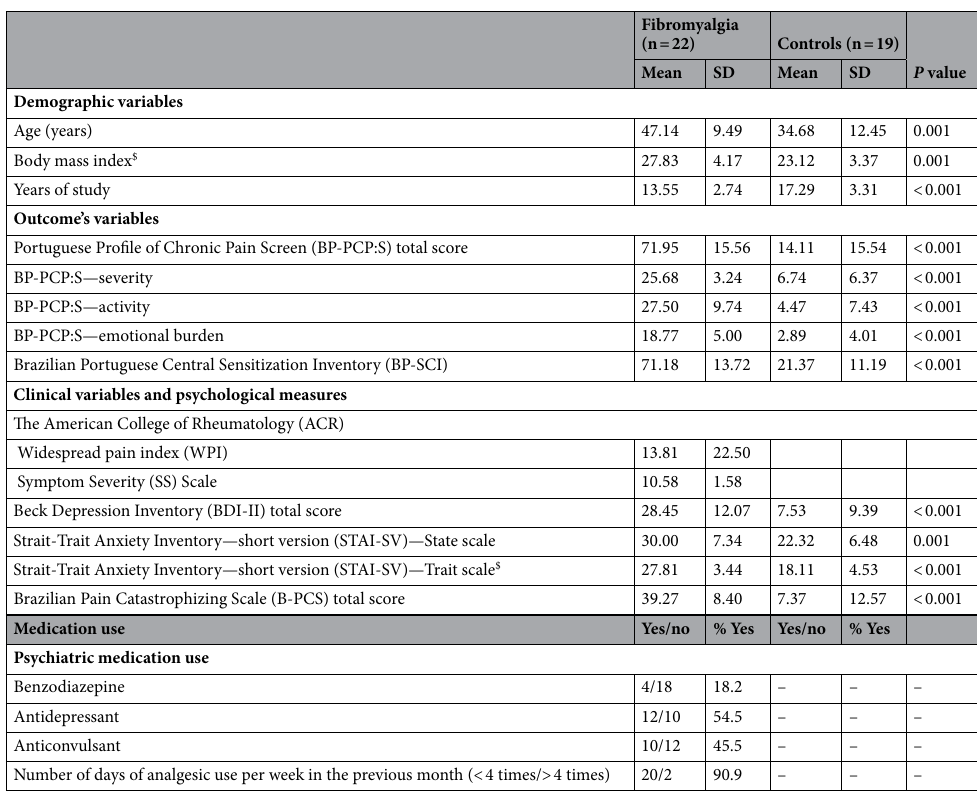
Table 1. Demographic and clinical characteristics for the total sample (n = 41). SD standard deviation. All P values are based on Mann–Whitney test, except for “regular analgesic use” which is based on Fisher’s exact test. $ = missing data for FM group with n =